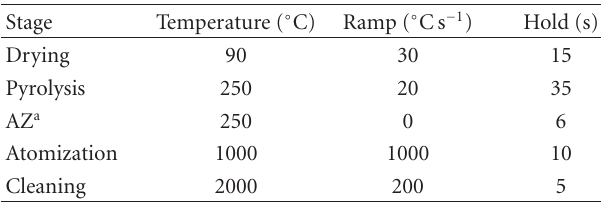
Table 2: Temperature program (according to study [1]) for treatment of platform after the electrodeposition of modifiers from a drop of